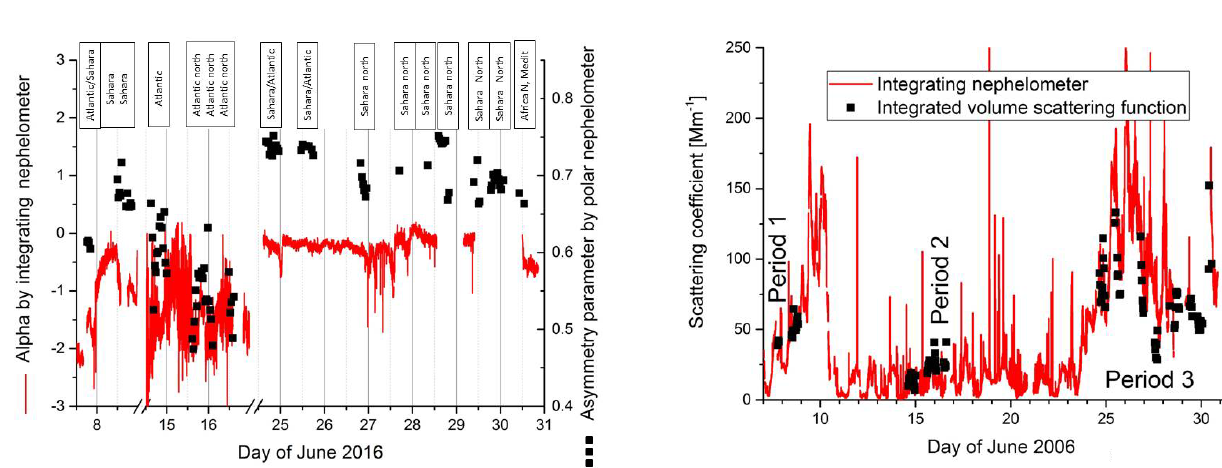
Figure 5. Measured scattering coefficient of the aerosol during the three periods of observation. The solid red line is the signal of the Integrating Nephelometer; the points are scattering coefficients ob- tained by integrating the measured volume scattering